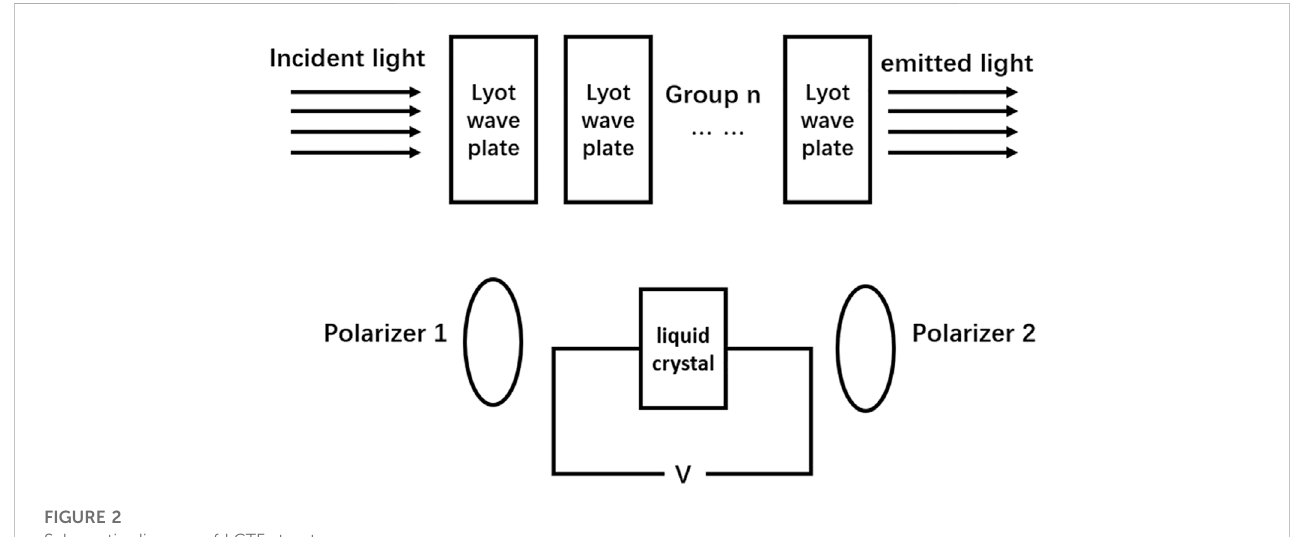
FIGURE 2 Schematic diagram of LCTF